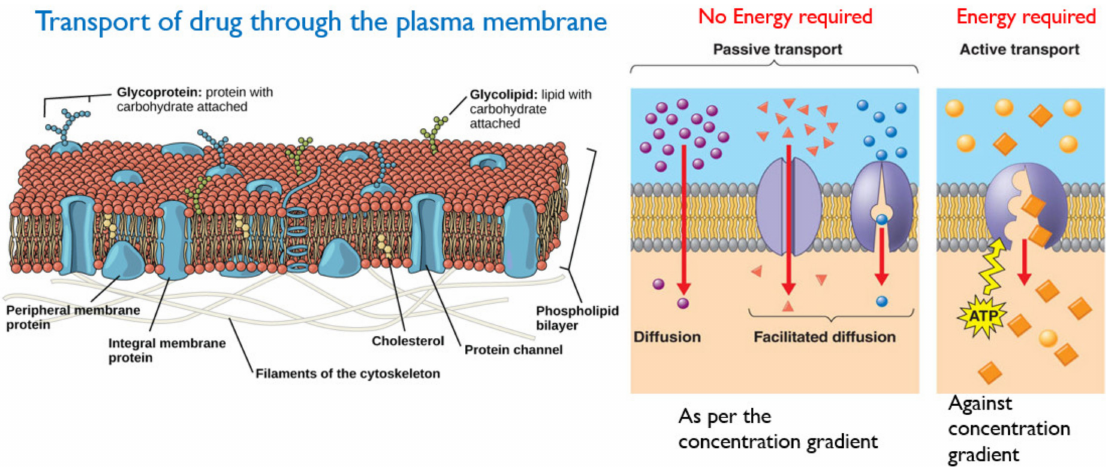
Figure 11. Schematic of transport of drug through the plasma membrane by passive transport and active transport (reproduced from [34] with permission from the OpenStax, (part of Rice University, which is a 501(c)(3) nonprofit) and [35] licensed under Creative Commons Attribution (CC BY 4.0) international